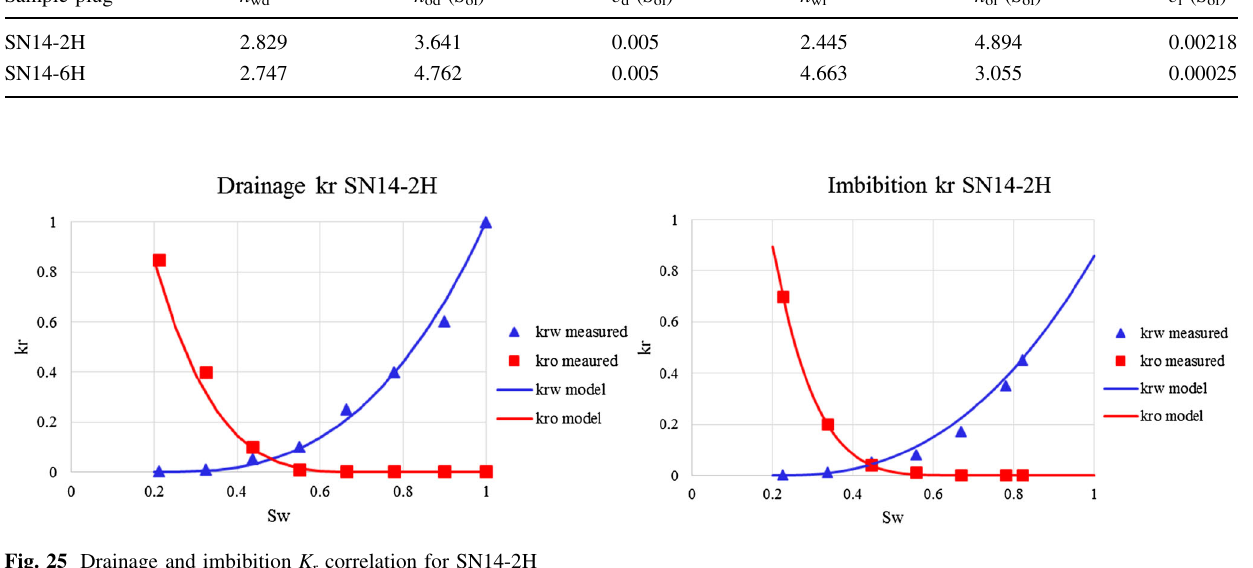
Table 11 Fitting parameters of K r correlation for core samples Sample plug